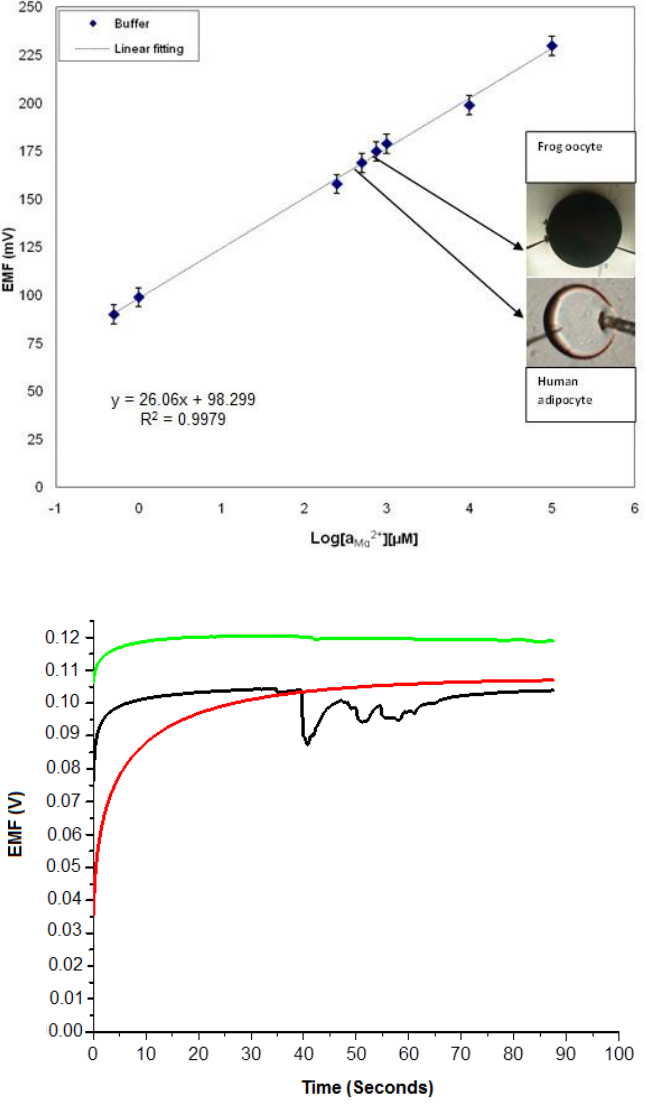
Figure 10. ( Top ) Calibration response curve of the Mg 2+ sensor vs. reference electrode. The inset shows images of frog and human cells. ( Bottom ) The output response curves without (red) and with (black and green) interfering ions in the analyte solution